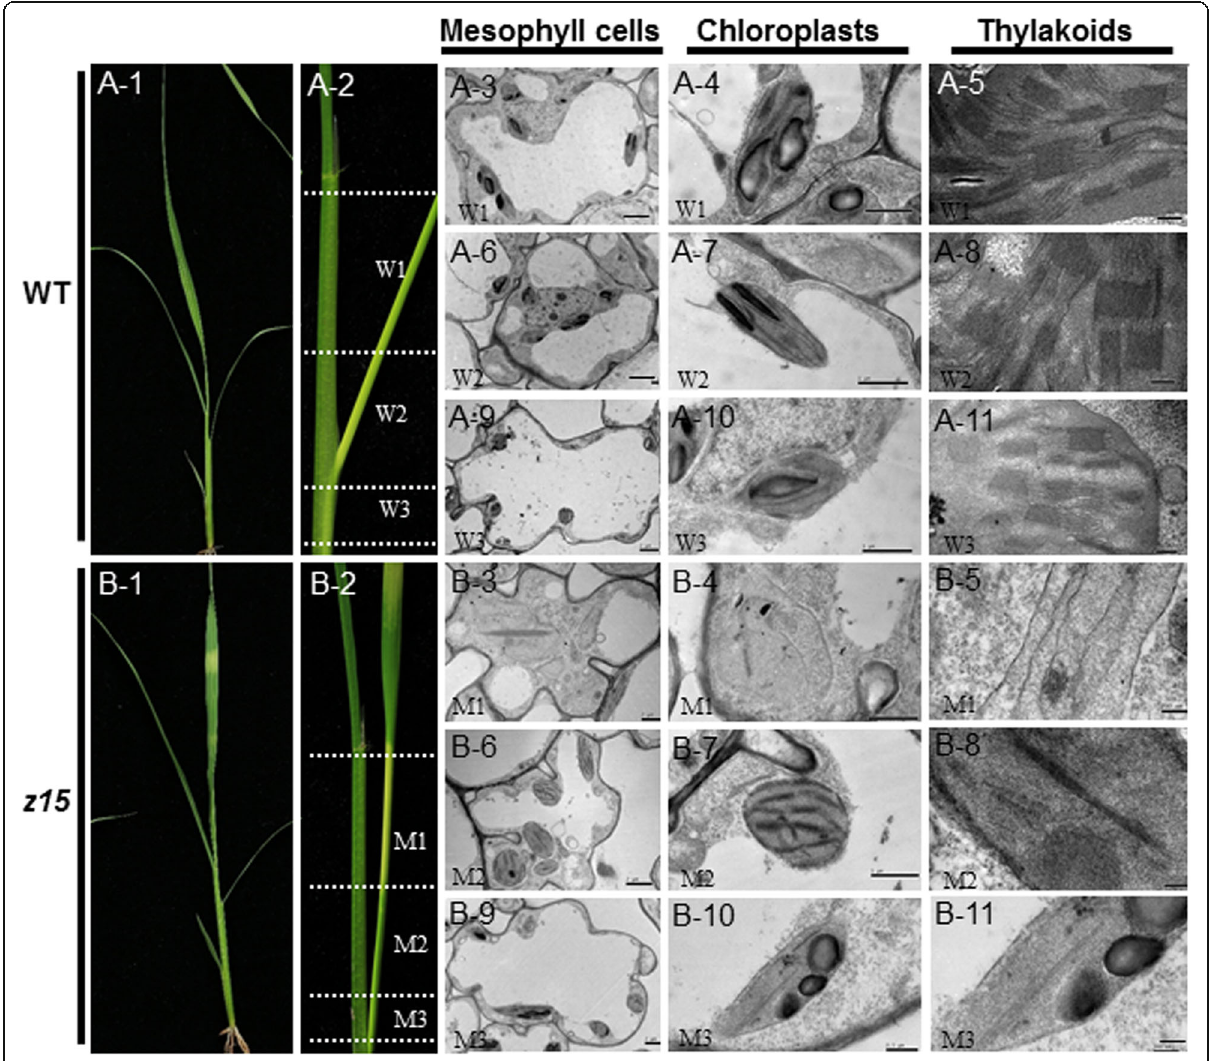
Fig. 1 Phenotype of the wild type (WT) and z15 mutant and transmission electron micrographs of chloroplasts from wrapped leaves. WT (W1, W2, W3), z15 (M1, M2, M3). A-3, A-6, A-9, B-3, B-6, B-9: bars = 2 μ m. A-4, A-7, A-10, B-4, B-7: bars = 1 μ m. B-10: bar = 0.5 μ m. A-5, A-9, A-11, B-5, B-8, B-11: bars = 200